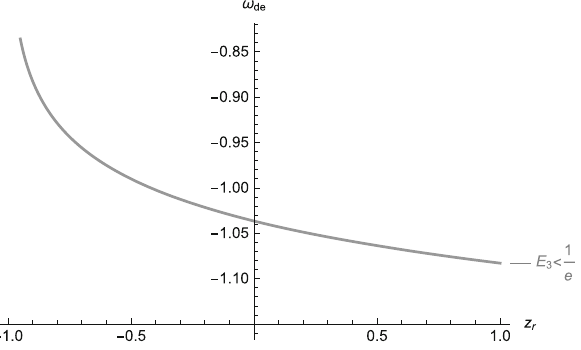
Fig. 27 The plot for ω de with respect to z taking α 2 = 3 . 05 > 3 and γ = 4